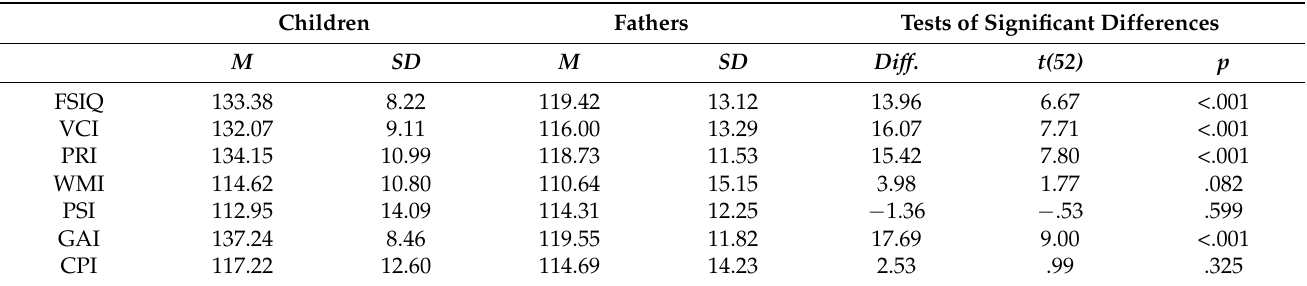
Table 9. Descriptive statistics and tests of significant differences between WAIS-IV and WISC-IV scores in father-child